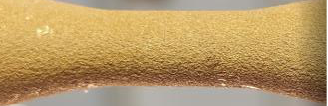
Figure 13. Macroscopic view of the surface of sample H (4340) after 5 million cycles.